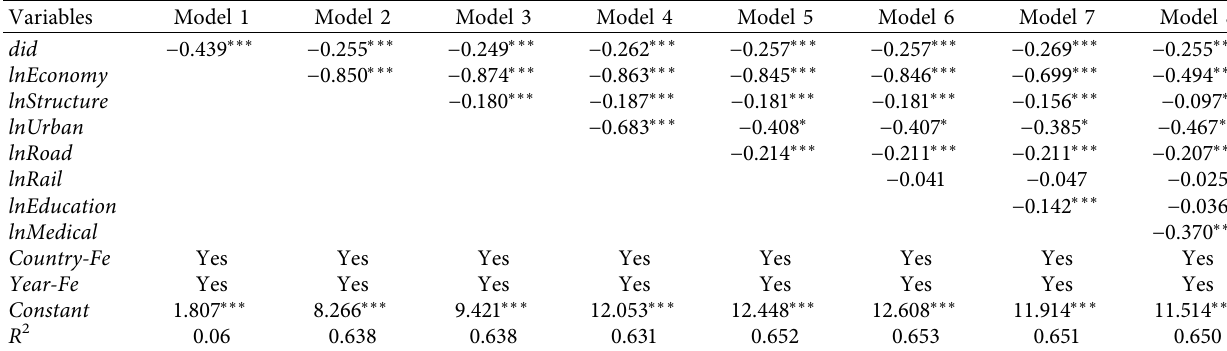
Table 3: Overall regression results.